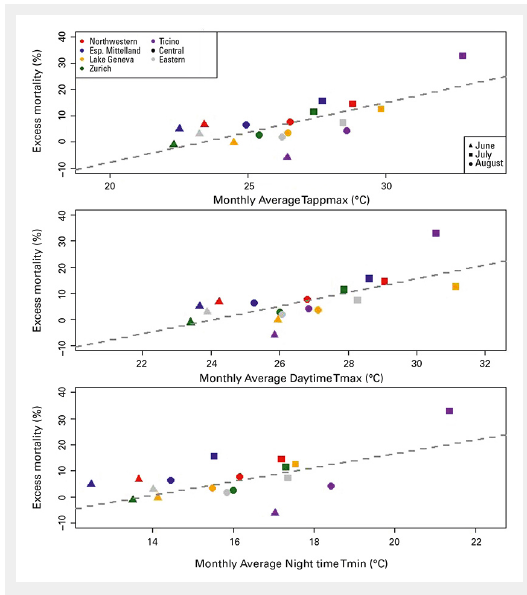
Relationship between monthly average temperature and estimated excess mortality (%) in each great region during summer